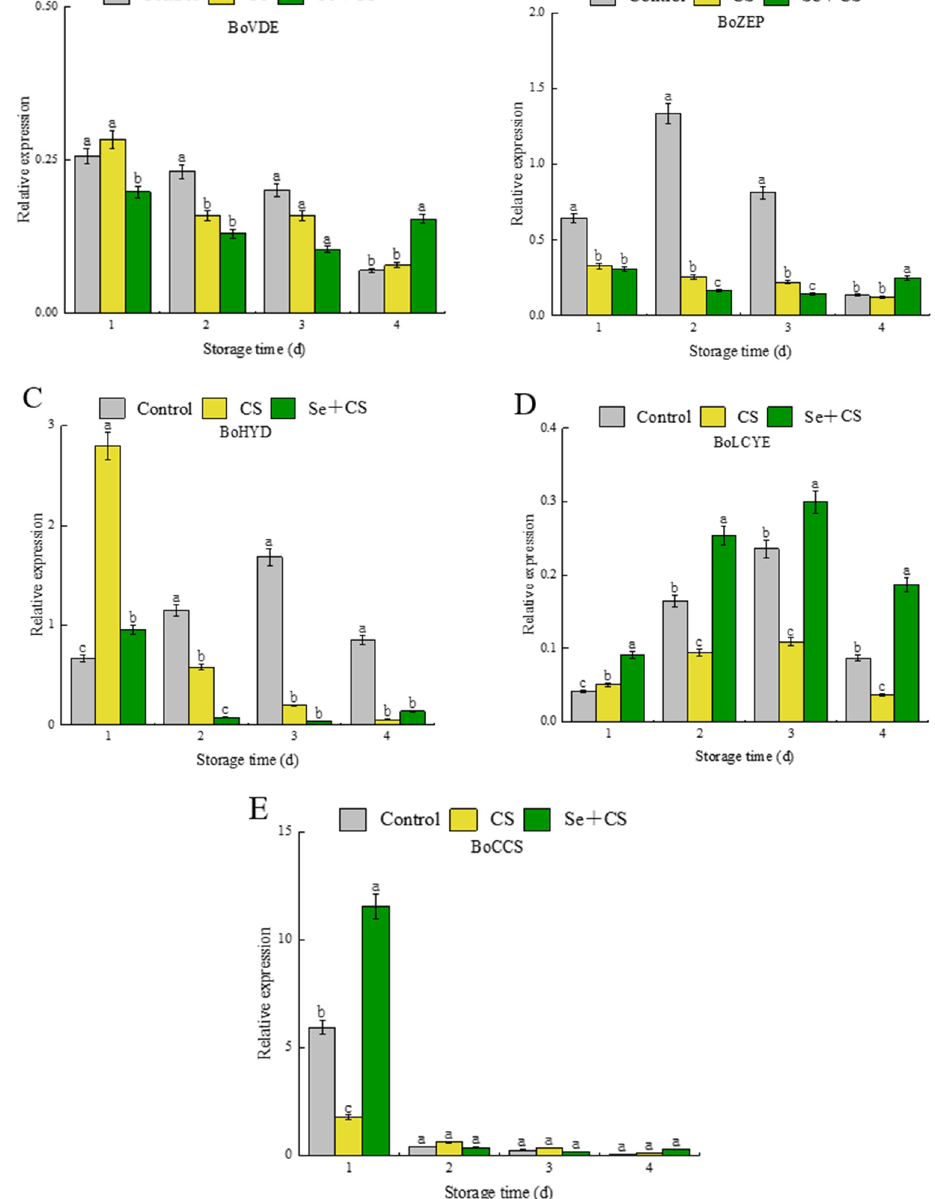
Figure 5. Relative gene expressions of carotenoid synthesis-related genes in broccoli treated with Se+CS during storage. ( A ). BoVDE . ( B ). BoCCS . ( C ). BoLYCE . ( D ). BoZEP . ( E ). BoHYD . Different letters represent significant differences in the same group during storage ( p < 0.05) by Duncan’s multiple range test.